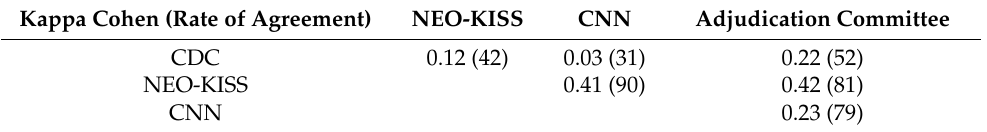
Table 2. Concordance study of the international US Centers for Disease Control and Prevention (CDC)/Canadian Neonatal Network (CNN)/ German National Reference Centre for Nosocomial Infection Surveillance in Neonatal Intensive Care Units (NEO-KISS) classification of the adjudication committee in 2 groups: Cohen’s kappa and rate of agreement matrix.